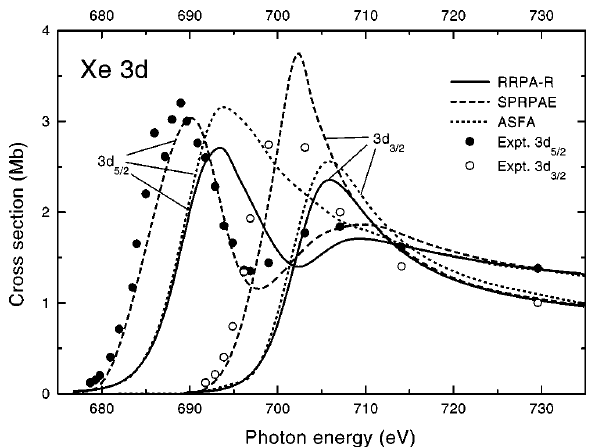
FIG. 2. Photoelectron angular distribution anisotropy parameter b for the 3 d shell of xenon. Solid lines represent the 13-channel RRPA- R parameter b for 3 d 5/2 and 3 d 3/2 subshells calculated in the present work. The length and velocity gauge results differ at most by 0.005 and are indistinguishable in the scale of the figure. Dashed lines represent the results of SPRPAE calculations @ 12 # . Dotted- dashed lines represent the results of the ASFA calculations @ 1 # as calculated by the authors, without shifting in the original figure of their work. Closed and open circles denote the experimental results for respective 3 d 5/2 and 3 d 3/2 subshells determined from one type of measurements ~ I ! , and open triangles denote the two sets of b values for 3 d 5/2 measured with a different setup ~ II ! @ 1 # .